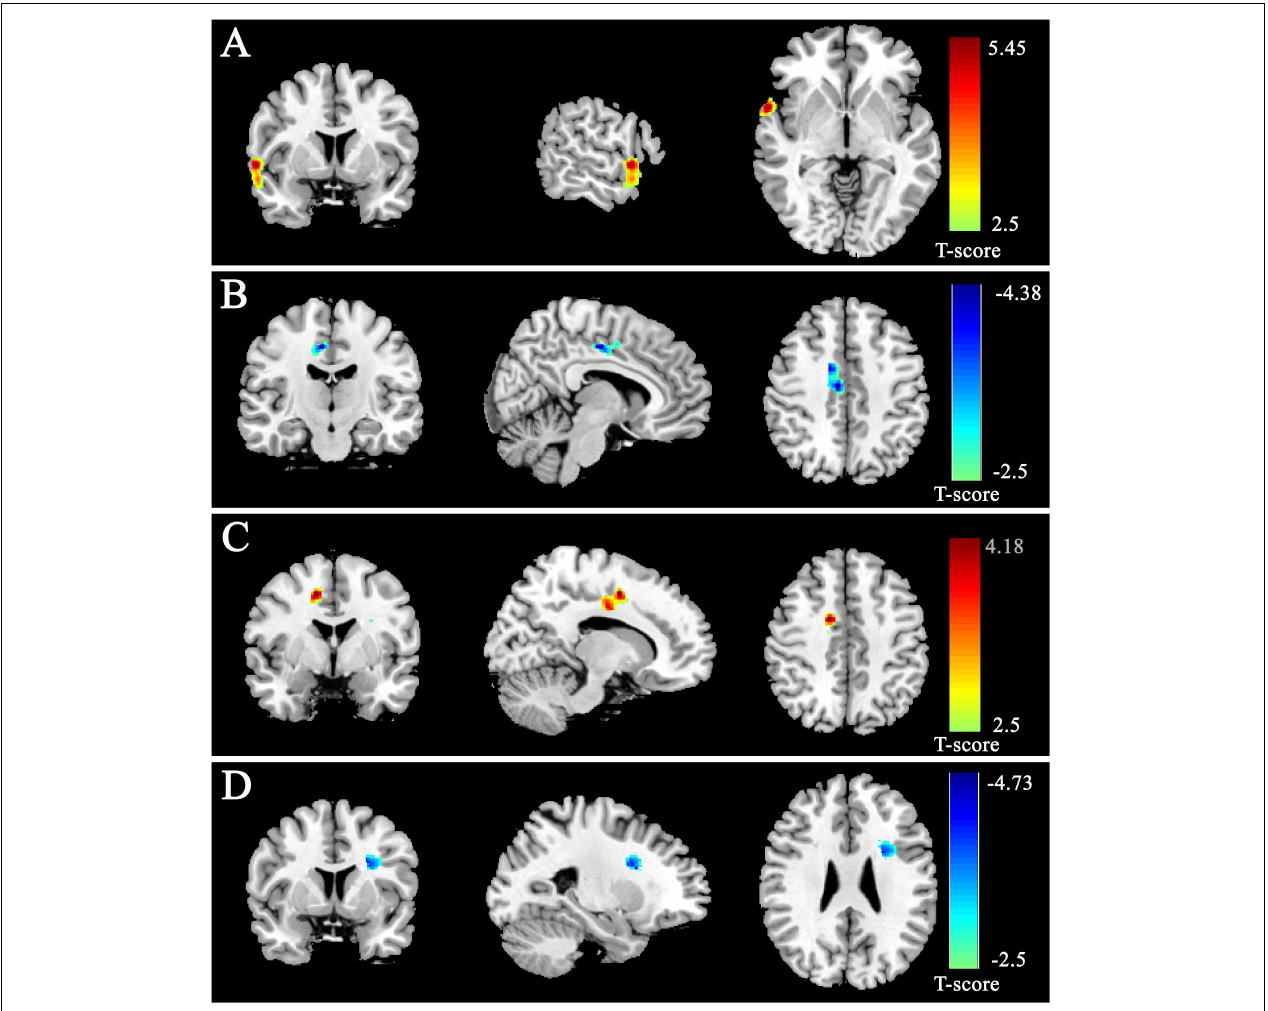
FIGURE 2 | Gray matter density (GMD) and white matter density (WMD) were correlated with RAT scores. GMD was positively correlated with RAT scores in anterior STG (A) and negatively correlated with RAT scores in dorsal ACC (B) . WMD was positively correlated with RAT scores in dorsal ACC (C) and negatively correlated with RAT scores in IFG (D) . All results were shown at t > 2.5 for visualization purpose.